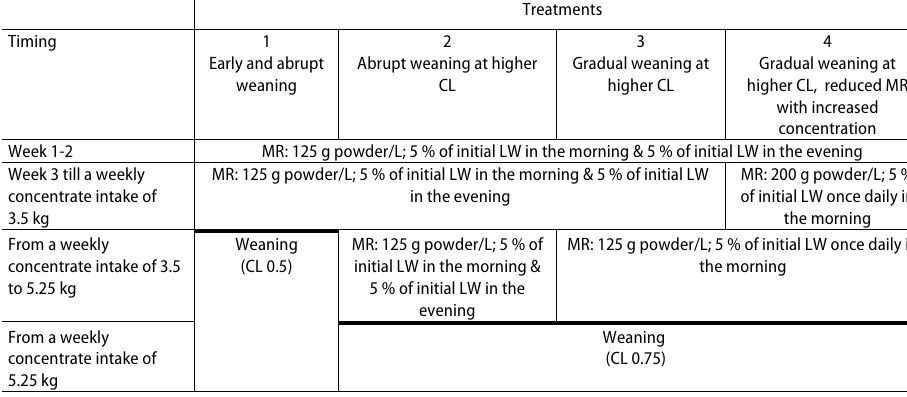
Treatments 2 3 4 Abrupt weaning at higher Gradual weaning at Gradual weaning at higher CL, reduced MR with increased concentration